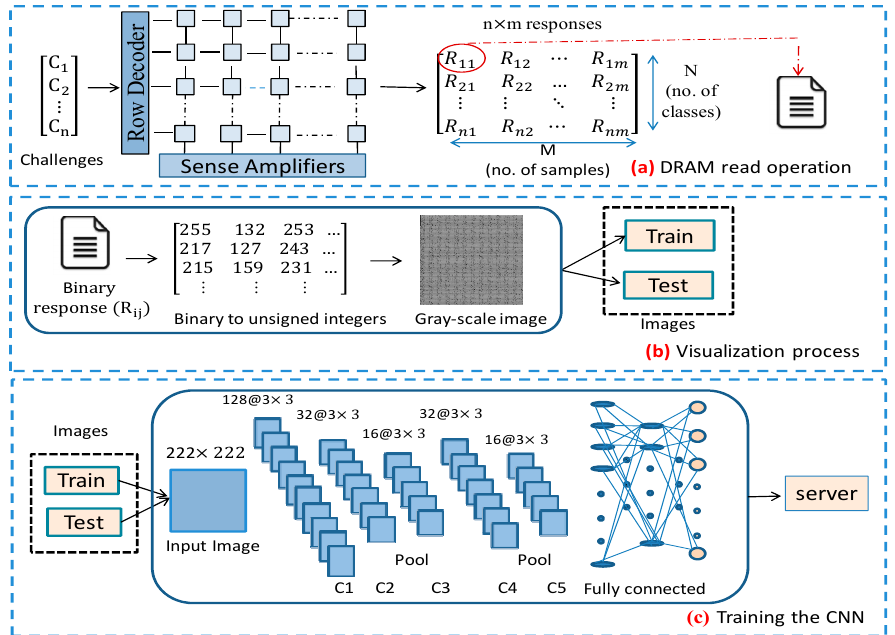
Figure 3. Enrollment Phase.